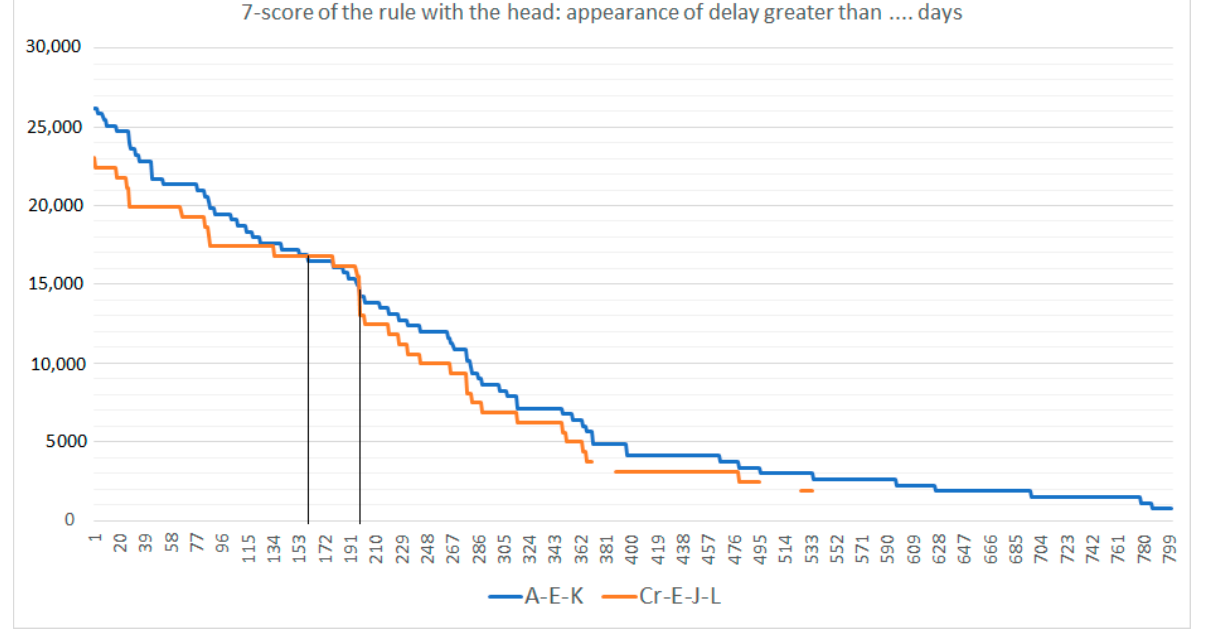
Figure 11. The 7-Score values of the rules for A-E-K and Cr-E-J-L for different numbers of days as the threshold of the head (delay).